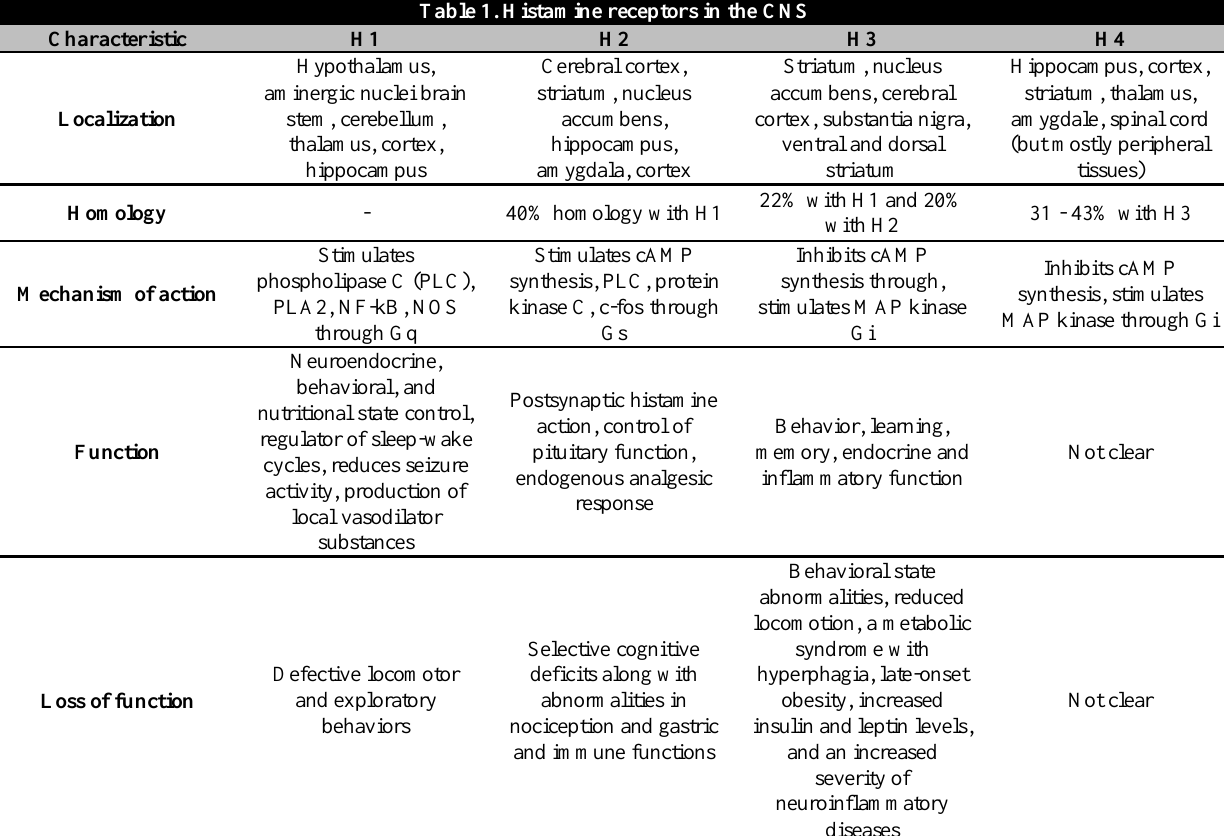
Table 1. Histamine receptors in the CNS